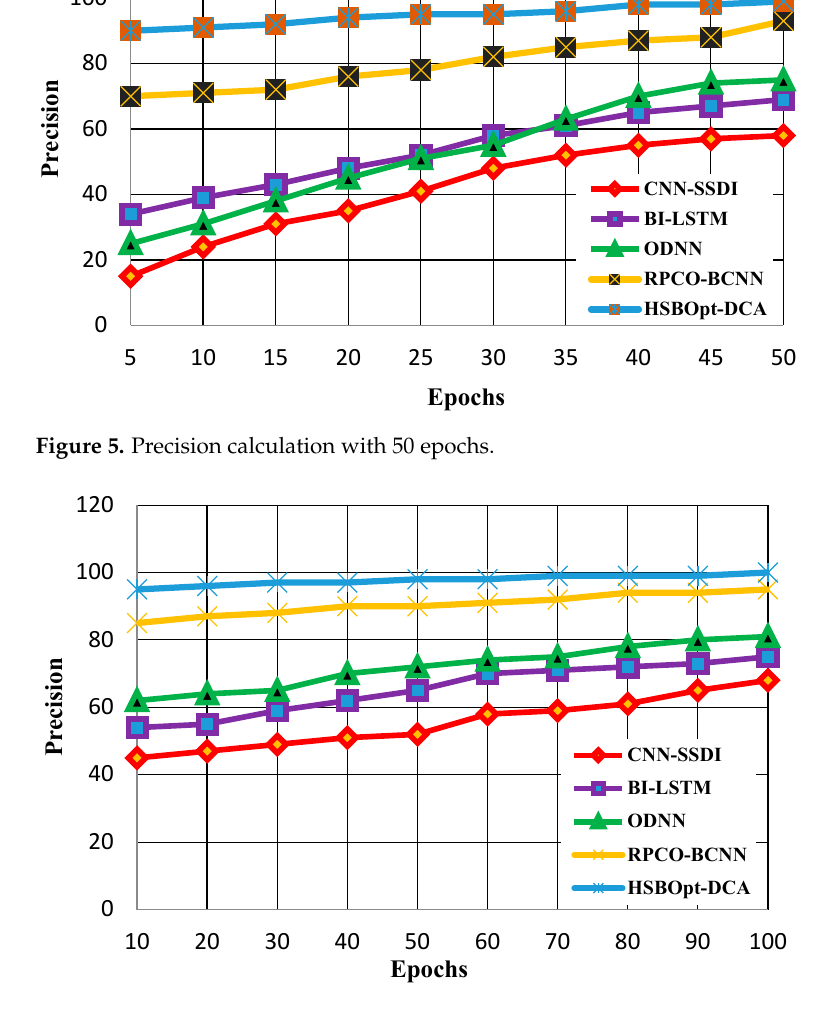
Figure 6. Precision calculation with 100 epochs.